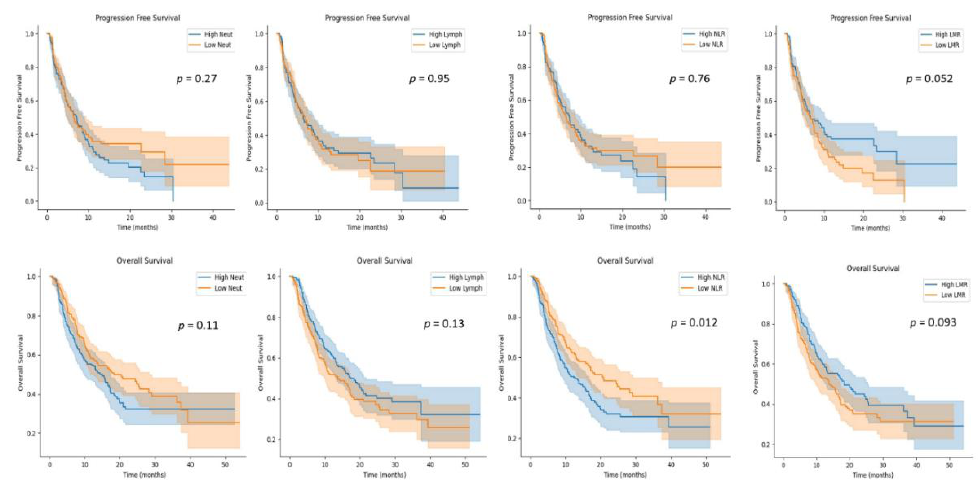
Figure 3. Kaplan–Meier curves for PFS and OS according to blood indexes